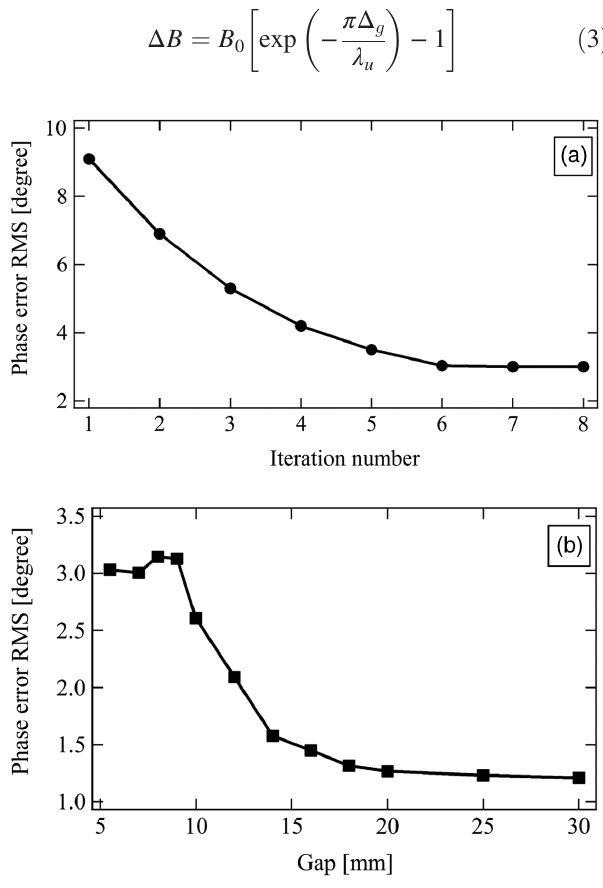
FIG. 12. Warming up the undulator to room temperature. (Blue) Undulator vacuum pressure, (Red) permanent magnets temperature.